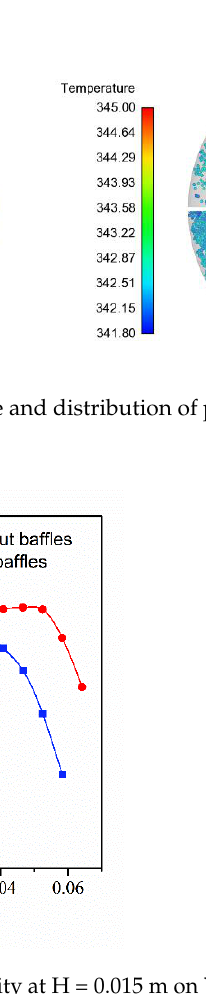
Figure 20. Comparison of the radial velocities of different heights at r/R = 2/3 of the stirred tanks with and without baffles.